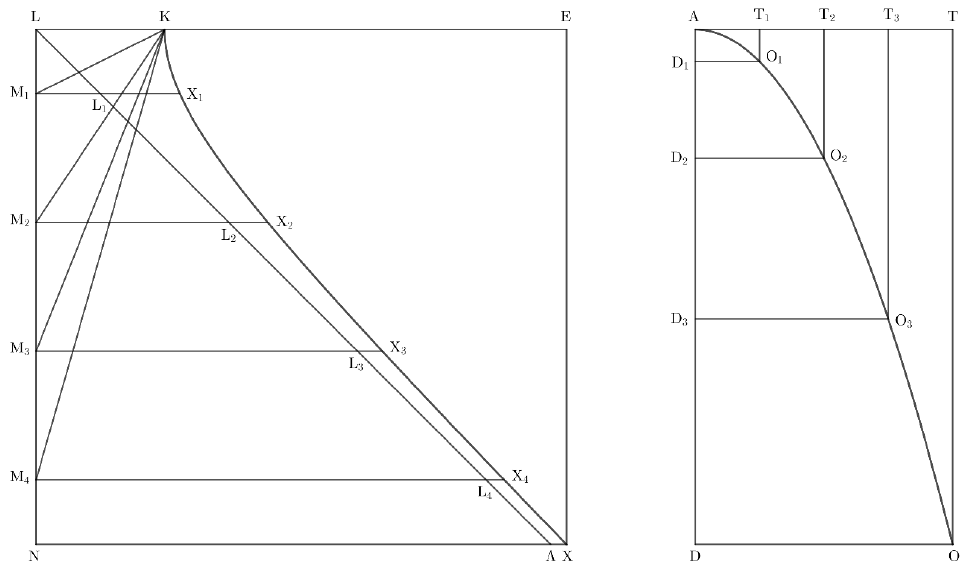
Figure 5. Correspondence between the hyperbola 𝐾𝑋 𝑖 𝑋 , the triangle 𝐿Λ𝑁 (left panel), and the arc of the parabola 𝐴𝑂 𝑖 𝑂 (right panel) in Wallis’ method to obtain the quadrature of the hyperbola the parabola AO i O (right panel) in Wallis’ method to obtain the quadrature of the hyperbola starting starting from the length of the parabola and vice versa. from the length of the parabola and vice